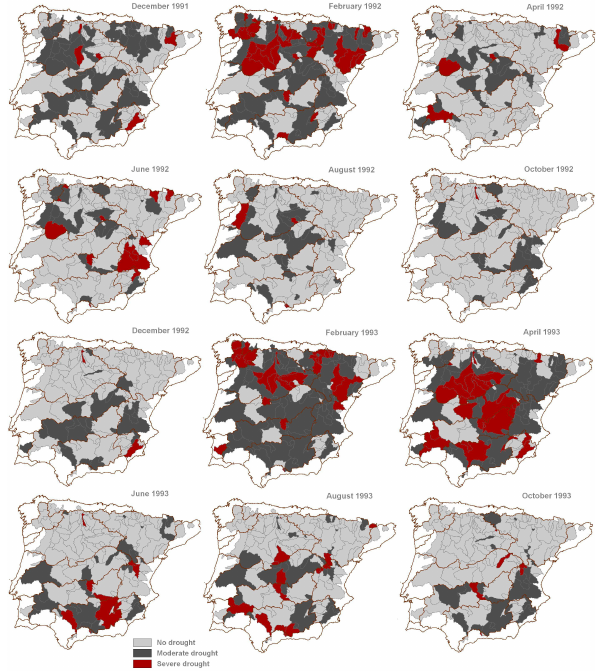
Fig. 9. Spatial coverage of the affected areas during the 1992–1993 drought. Dark grey depicted moderate drought conditions and red depicted severe drought